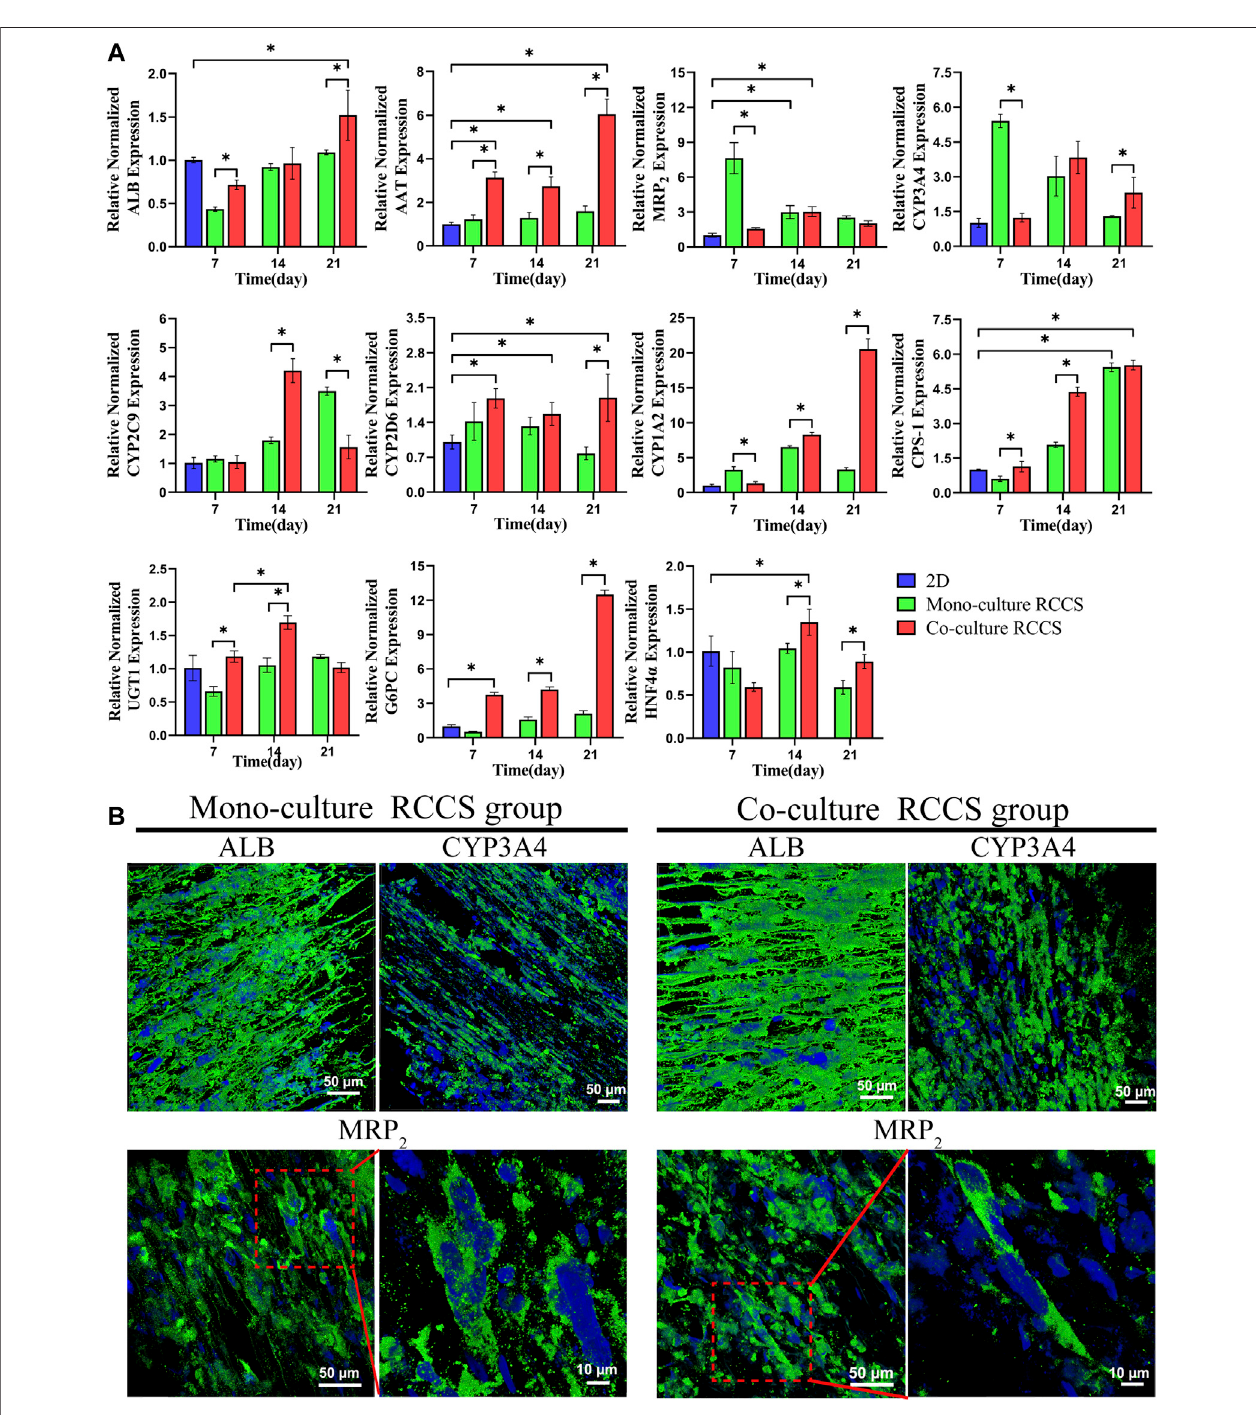
FIGURE7| FunctionalgeneandproteinexpressionindifferentcultureconditionsusingRT-qPCR (A) andIFstaining (B) .Higherfunctionalgeneexpressionwasfoundinthe 3D co-cultures than in the 2D cultures and 3D monocultures (A) . iHepLPC-Heps in both groups expressed ALB, CYP3A4, and MRP 2 after 14 days of culture (B) . (* p < 0.05).